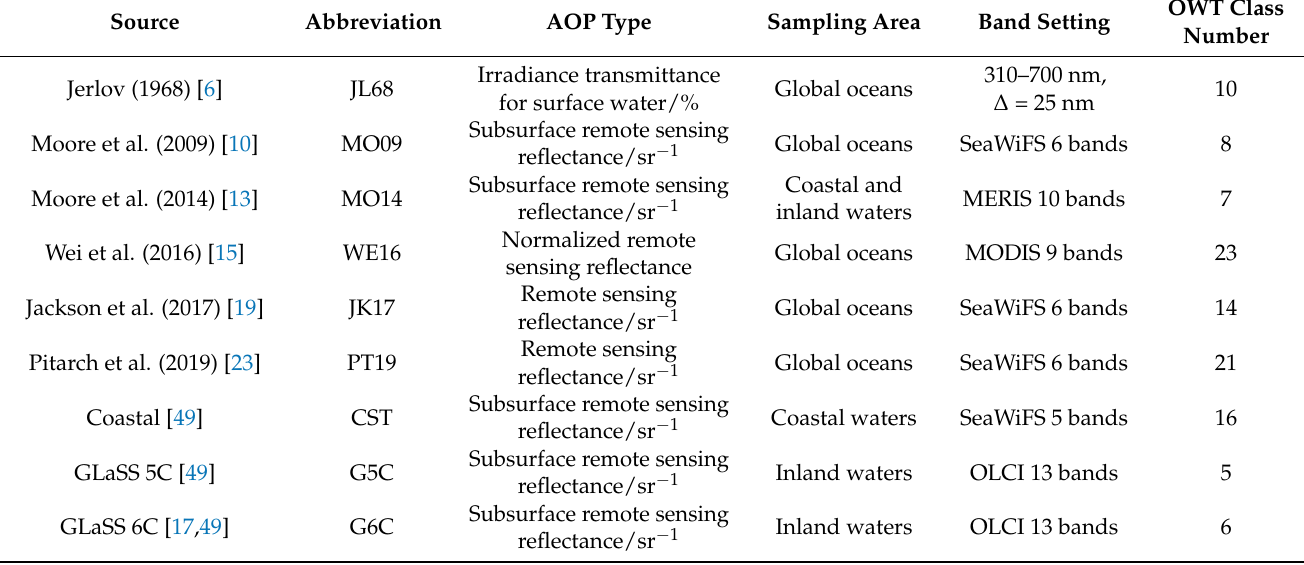
Table 1. Introduction to different AOP-based water classification schemes.